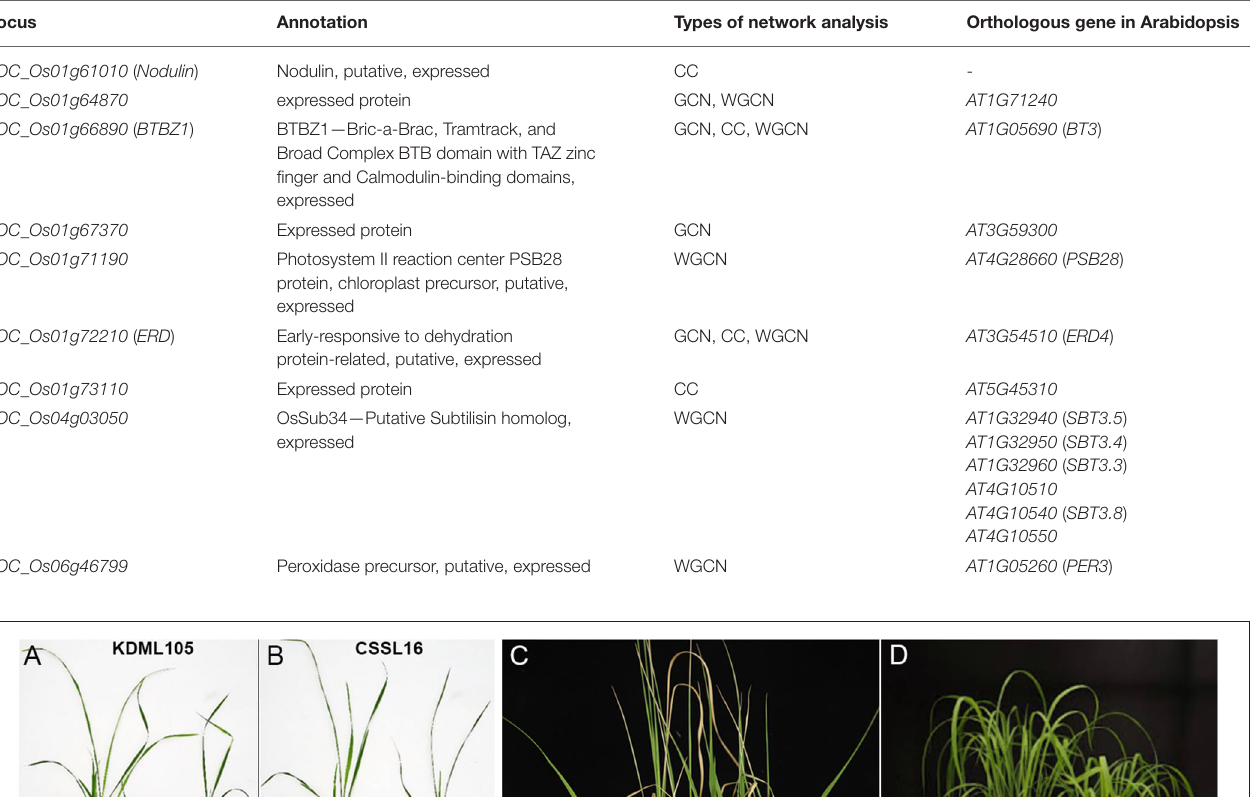
TABLE 4 | Putative salt tolerance genes predicted by GCN, CC, and WGCN containing SNPs between CSSL16 and “KDML105” rice. Locus Annotation Types of network analysis